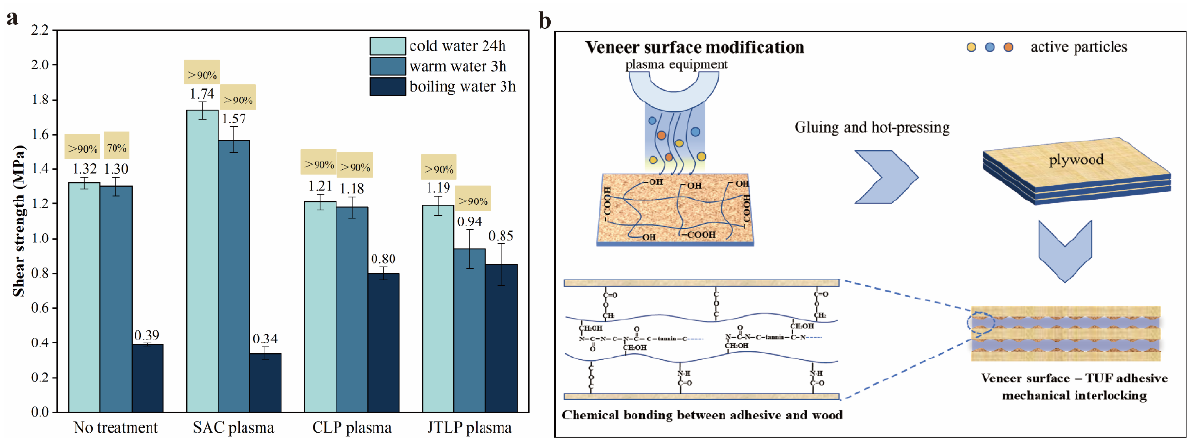
Figure 9. ( a ) Shear strength of plywood specimens prepared with veneer exposed to varied regimes of plasma treatments using different equipment; ( b ) Plasma illustration (the highlight indicates the wood failure rate in Figure 8a).